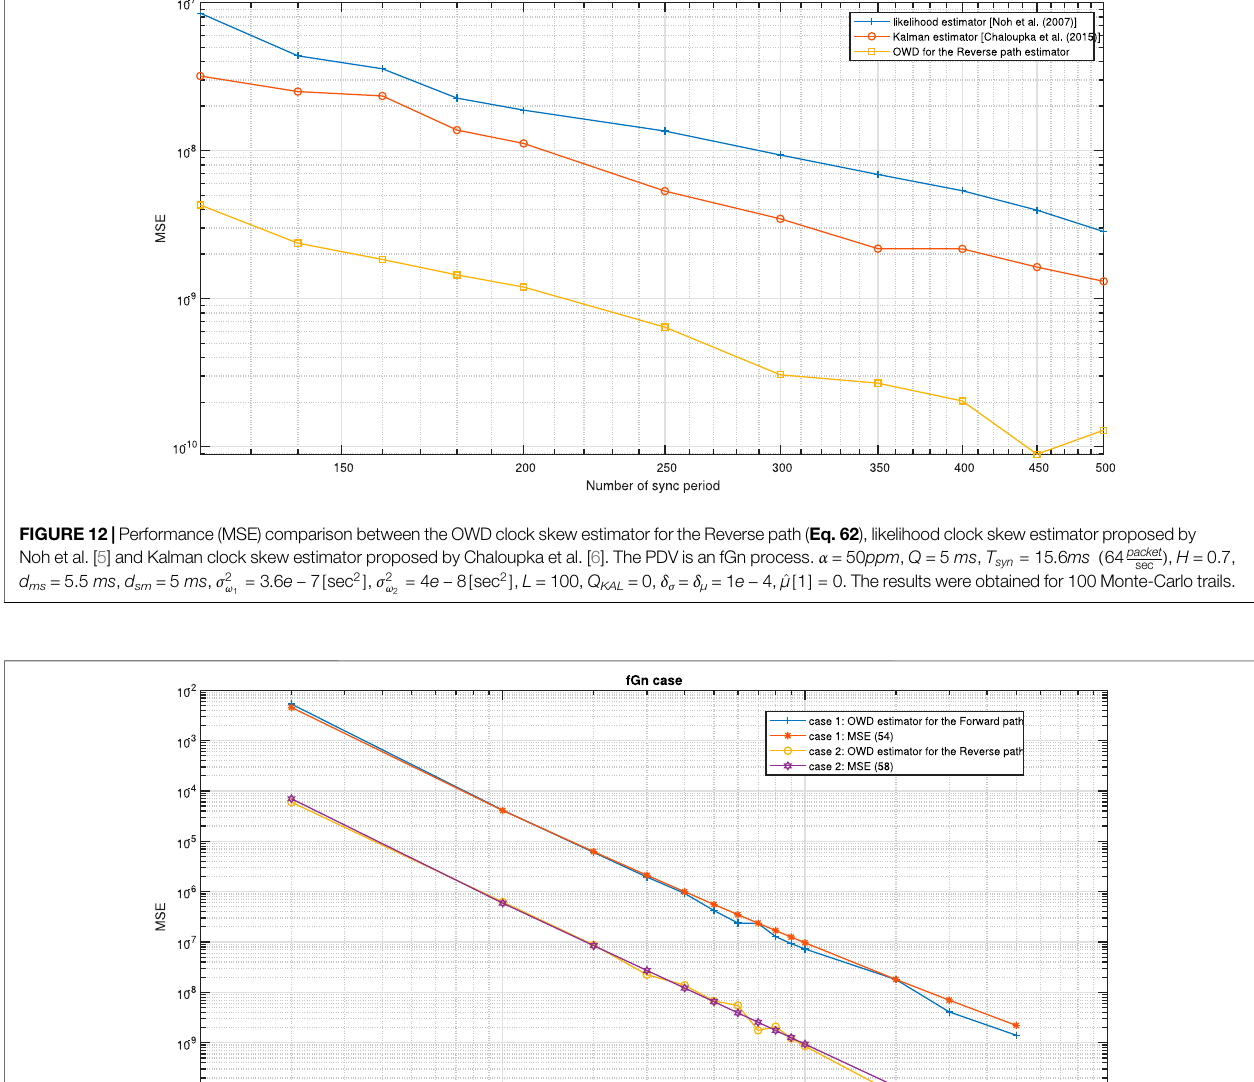
FIGURE 13 | case 1: Performance comparison for the fGn case, between our new proposed clock skew estimator for the Forward path ( Eq. 61 ) with the (cid:2) 0 . 8 e − 3 [ sec ] . Case 2: Performance comparison for the fGn case, between our new performance results for our new proposed expression for the MSE ( Eq. 54 ). σ ω 1 (cid:2) 0 . 1 e − 3 [ sec ] . proposed clock skew estimator for the Reverse path ( Eq. 62 ) with the performance results for our new proposed expression for the MSE ( Eq. 58 ). σ ω 2 For both cases: α = 50 ppm , Q = 5 ms , T syn (cid:2) 15 . 6 ms ( 64 packet sec ) , H = 0.6, d ms = 5.5 ms , d sm = 5 ms . The results were obtained for 100 Monte-Carlo trails.